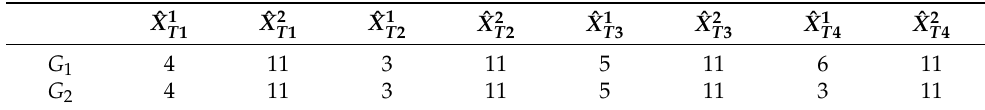
Table A2. Representative variables of the CORE-clusters tested Appendix A on G 1 and G 2 . Corre- sponding coherences are given Table